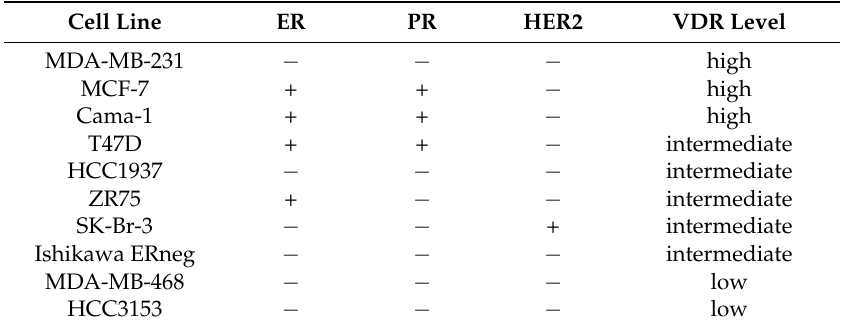
BC: breast cancer; ER: estrogen receptor; PR: progesterone receptor; VDR: vitamin D receptor; − : negative; +: